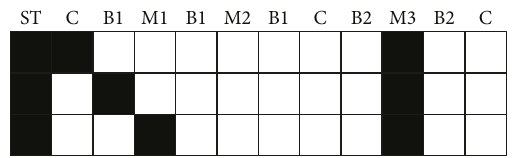
Figure 11: Evolution of the cellular automaton considering the boundary condition modi fi cation to the last fi ve cells to the right side of each con fi guration.